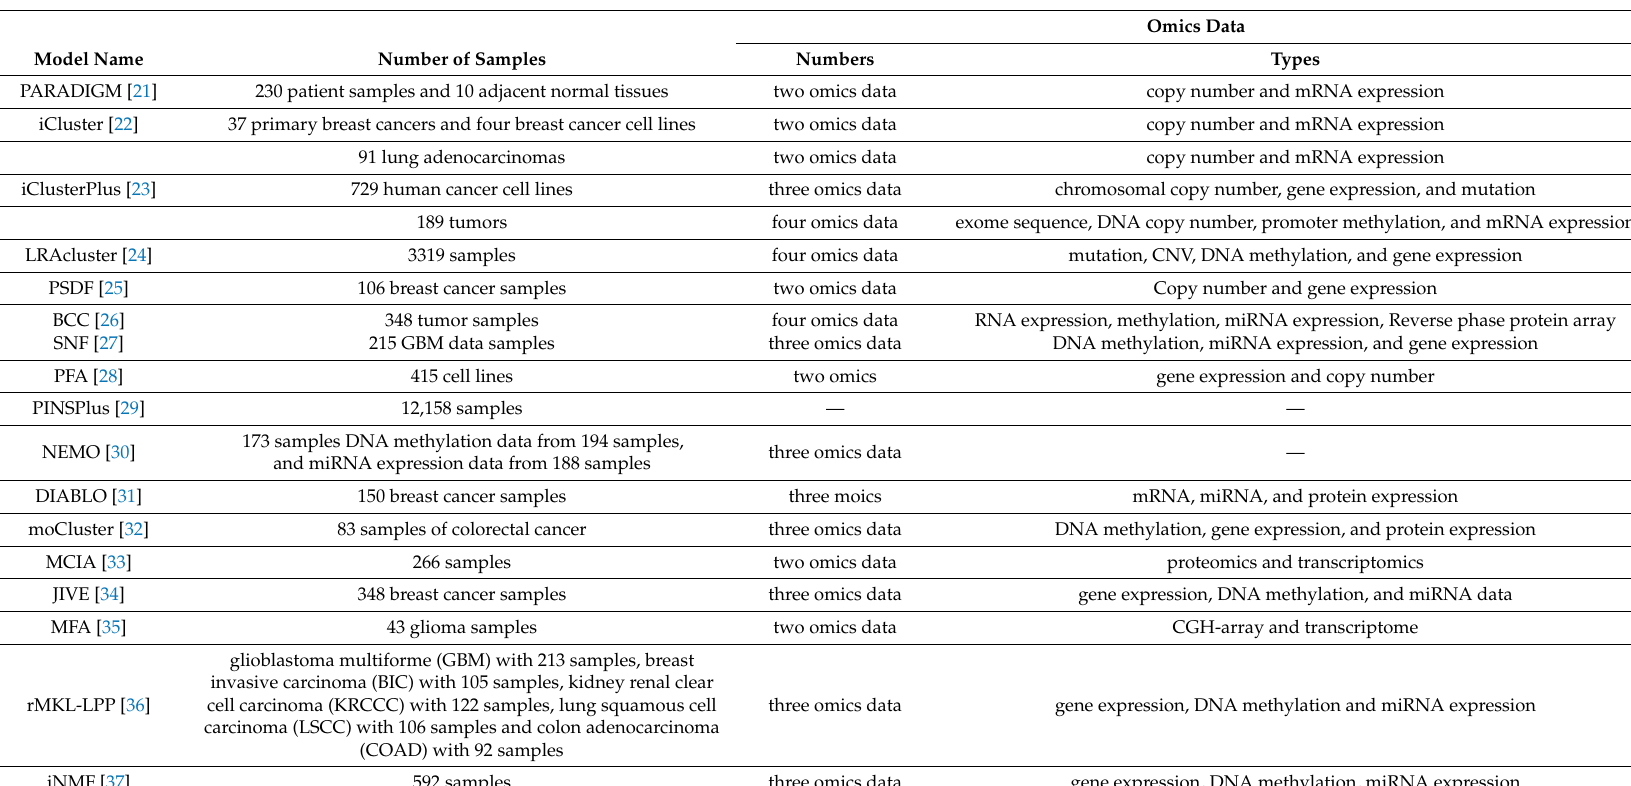
Table 1. List of number of sample as well as types of omics data analyzed in the review